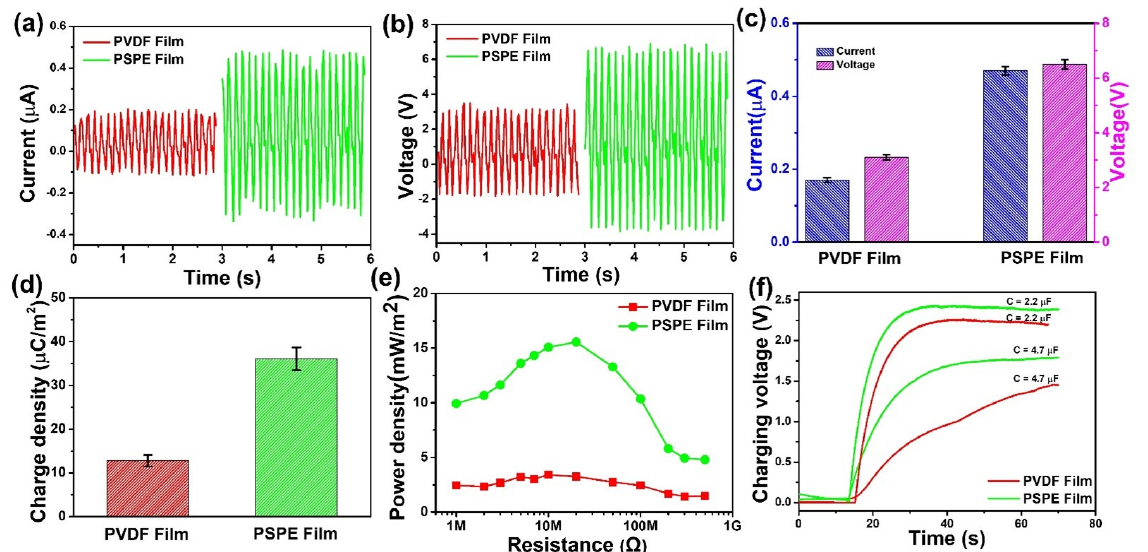
Figure 5. Electrical output characterization of PVDF and PSPE-TENG operated at a flow rate of 3 mL/s: ( a ) current, ( b ) voltage, ( c ) comparison of current and voltage, ( d ) charge density, ( e ) power density with loading resistances ranging from 1 M Ω to 500 M Ω , and ( f ) charging voltage curves for different